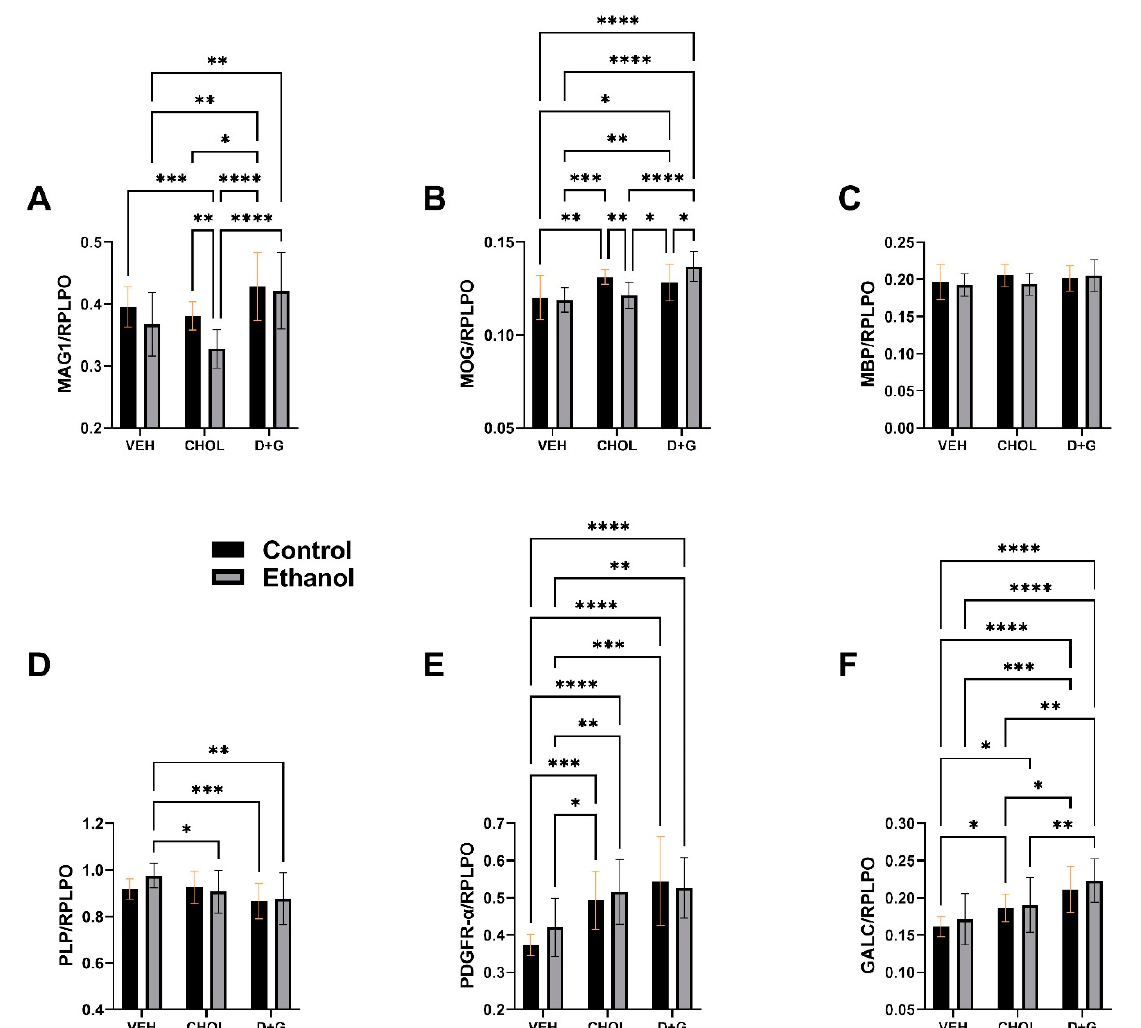
Figure 1. Ethanol and treatment (Chol and D+G) effects on ( A ) MAG1, ( B ) MOG, ( C ) MBP, ( D ) PLP, ( E ) PDGFR- α , and ( F ) GALC in rat frontal lobe slice cultures. Immunoreactivity was measured by duplex ELISA, with results normalized to RPLPO. Graphs depict the mean ± SD of results (N = 6 cultures/group). Inter-group differences were analyzed by two-way ANOVA (see Table 1) with post-hoc multiple comparisons using Tukey tests. * p < 0.05; ** p < 0.01; *** p < 0.001; **** p < 0.0001.